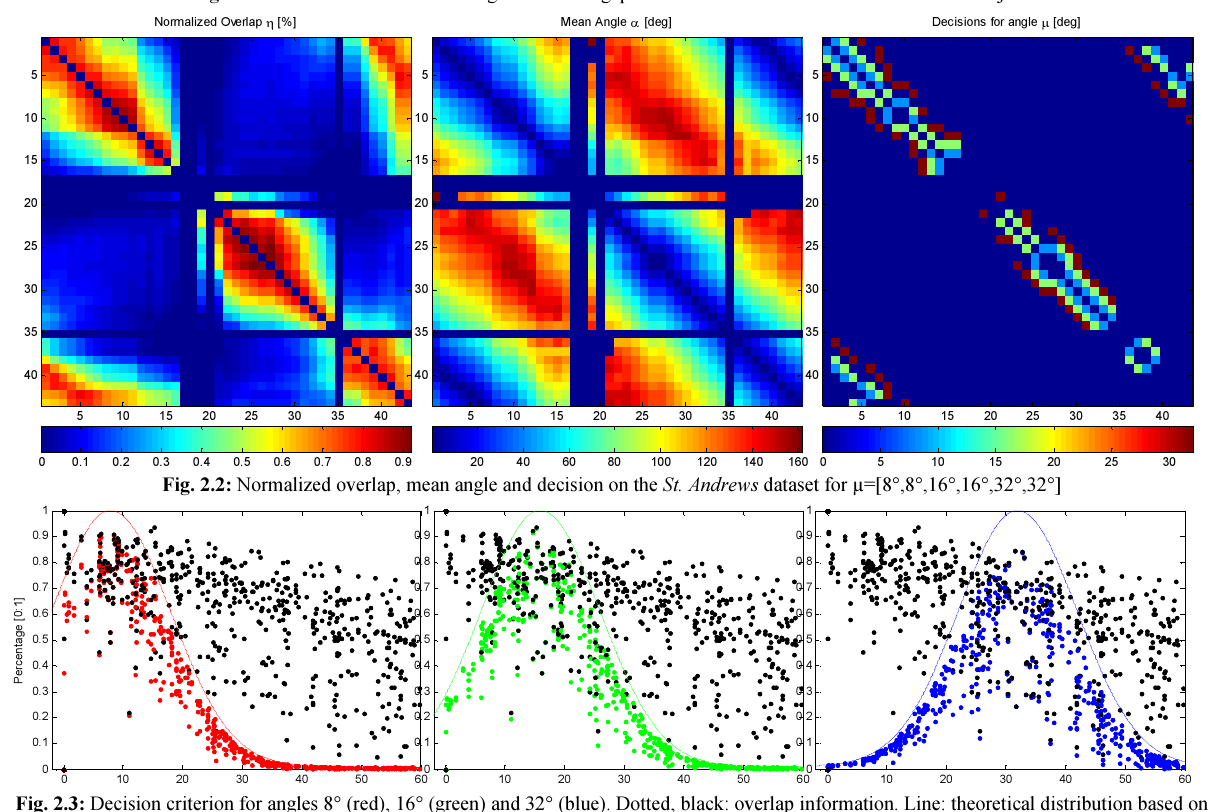
Fig. 2.3: Decision criterion for angles 8° (red), 16° (green) and 32° (blue). Dotted, black: overlap information. Line: theoretical distribution based on angle only. Dotted: effective distribution of criterion based on the angle including the overlap factor for St. Andrews example dataset.